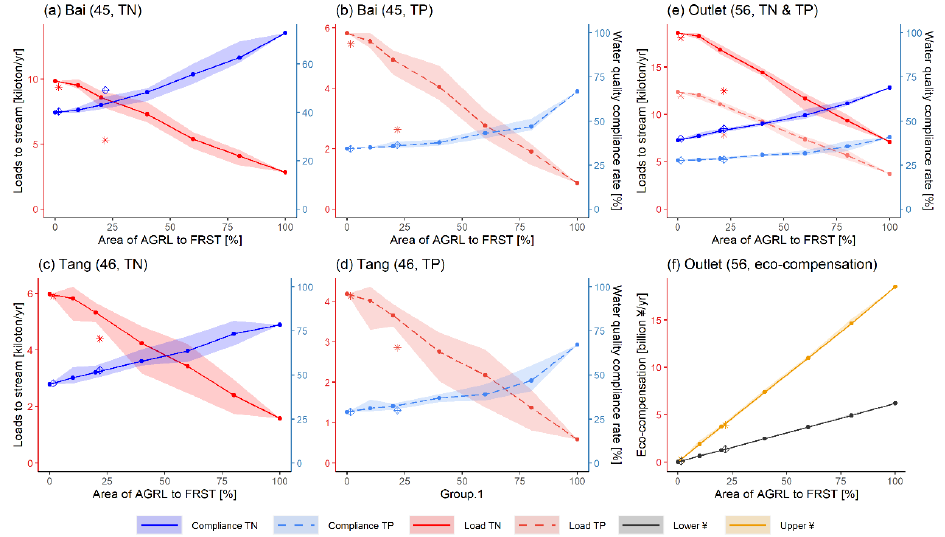
Figure 7. Effects of converting drylands (AGRL) in Henan to forest in terms of TN and TP leaching into reaches from upstream subbasins and compliance rate of water quality (Class III water) in the individual controlled sections ( a – e ), and the value of eco-compensations in CNY based on opportunity cost (upper line, f ) and GFG compensation standard (lower line, f ). The ribbons are the range and means of the respective results for GFG based on certain area ratios, and the scatter diamonds and stars are results based on slopes.